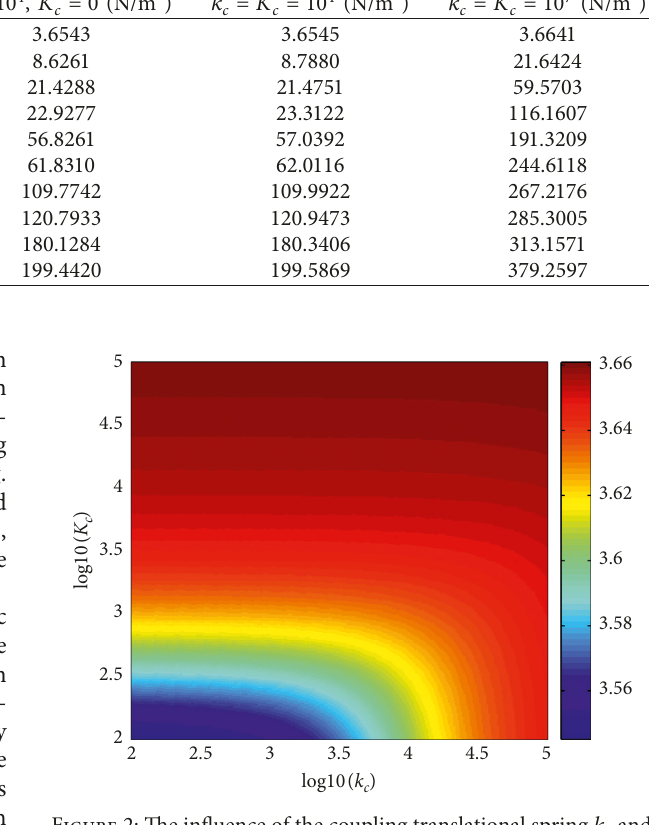
c and 0 . 2 and (cid:31)